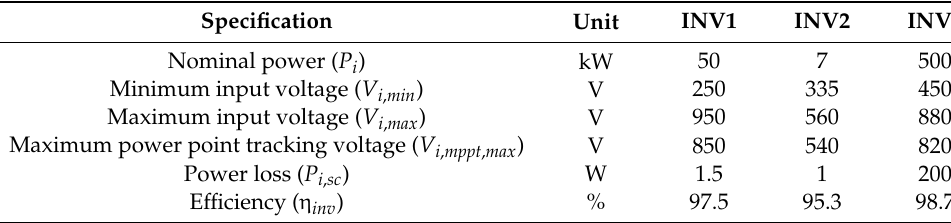
Table 6. Inverters specifications at standard test